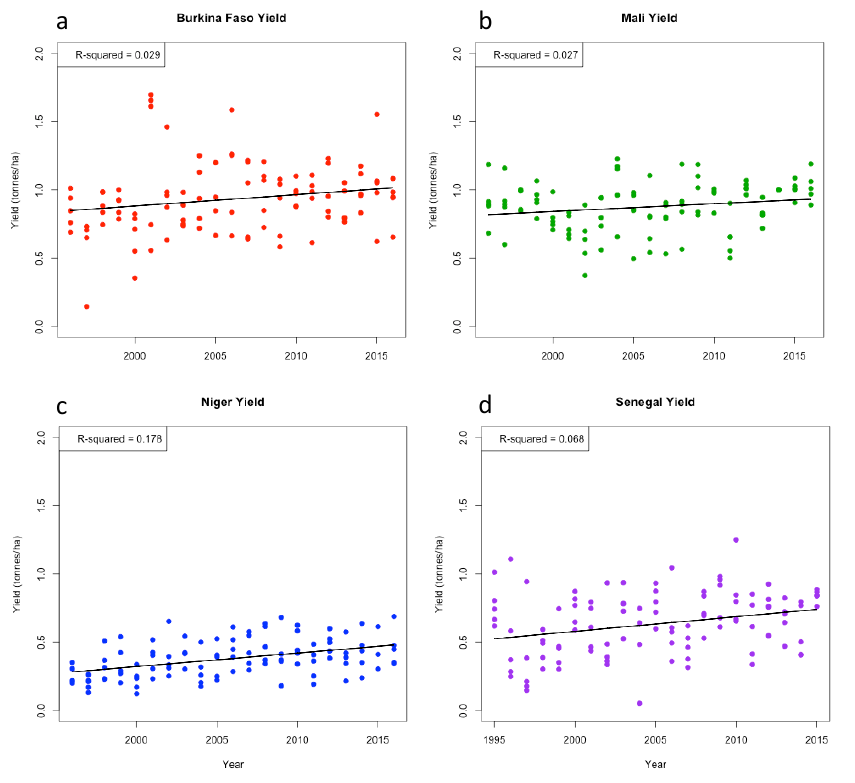
Figure A4. Yield (tonnes/ha) plotted against time for ( a ) Burkina Faso, ( b ) Mali, ( c ) Niger, and ( d )